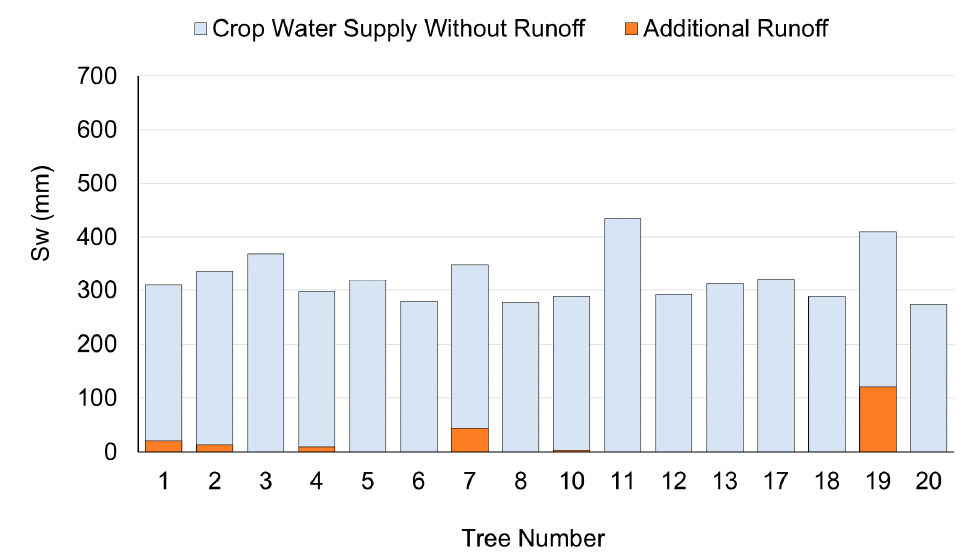
Figure 9. Mean water supply, S w (mm) per m 2 catchment area of 20 trees at Kufsteiner Straße in Berlin, mapped by using the parameters listed in Table 2. The black line indicates the average S w of all catchments. In red color: additional runoff to the tree pit increases the S w.